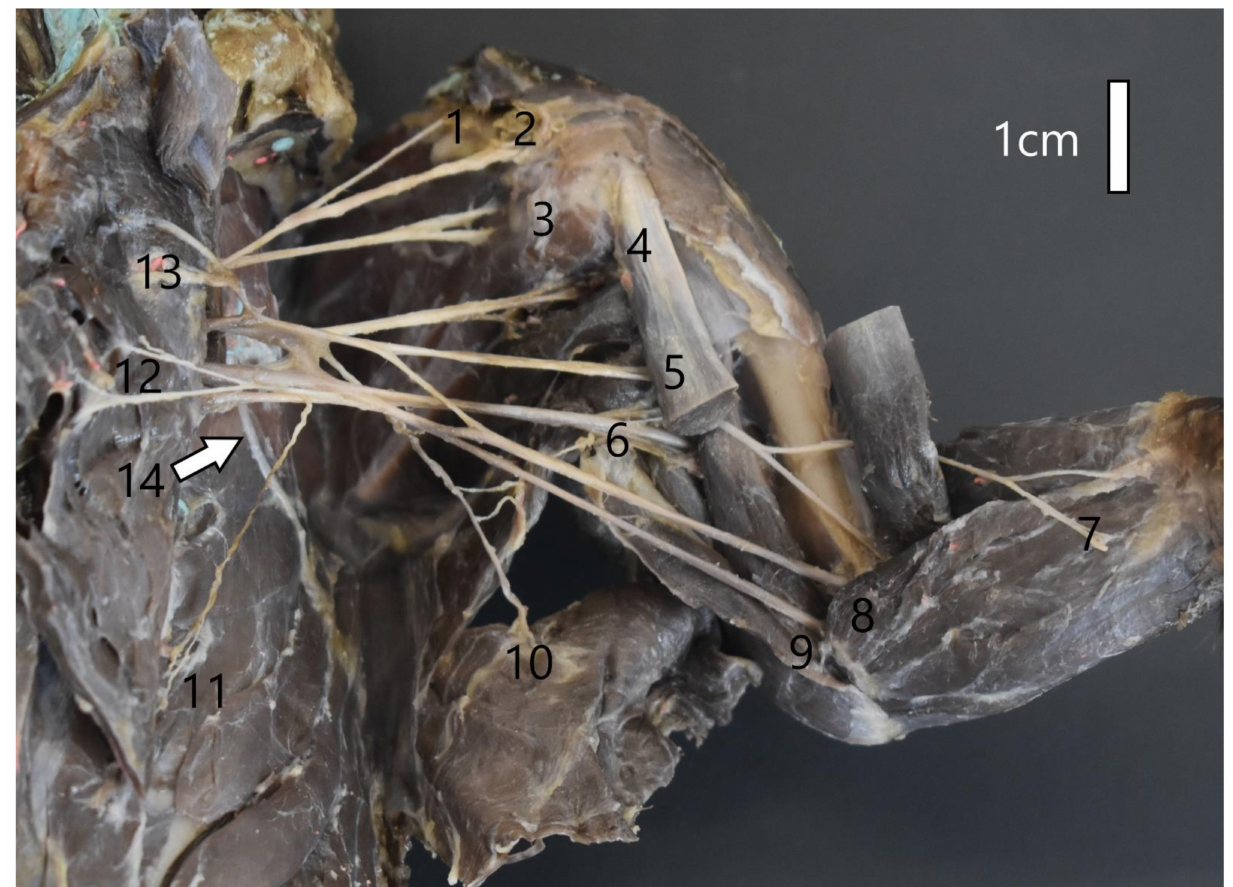
Figure 3. Structure of the left brachial plexus of the American mink ( Mustela vison ). 1—Brachiocephalic nerve; 2—Suprascapular nerve; 3,—Subscapular nerve; 4—Axillar nerve; 5—Musculocutaneus nerve; 6—Radial nerve; 7—Medial antebrachial cutaneous nerve; 8—Median nerve; 9—Ulnar nerve; 10—Thoracodorsal nerve; 11—Lateral thoracic nerve; 12—Caudal pectoral nerve; 13—Cranial pectoral nerve; 14—Long thoracic nerve. The ulnar nerve branched into a cutaneous ramus, i.e., the caudal antebrachial cuta- neous nerve ( n. cutaneus antebrachii caudalis ) and articular branches. Then it went towards the ulnar process and passed near the medial epicondyle. At the forearm level, together with the median nerve, it innervated the medial abdominal muscles. Before the wrist, it branched into the dorsal ramus, which innervated digit V (Figure 4). At the wrist level, it divided into the superficial branch and the deep branch. The deep branch ran towards the metacarpal bones, whereas the superficial branch ran towards the distal ends of the digits, forming the common palmar nerves. At the level of the digits, the proper palmar digital nerves IV and V and the abaxial digital nerve V were formed. The course of the ulnar nerve was consistent with this pattern in all the